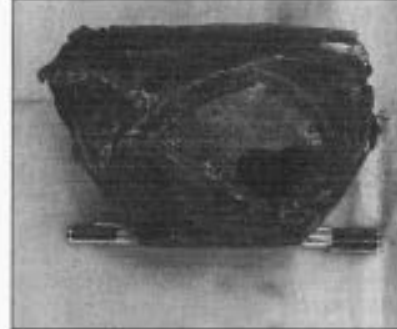
Figure 4 Coarseware pottery vessel with birch-bark binding, dated c. AD 1300, from the Fyodorovsky VI excavation (Fig.